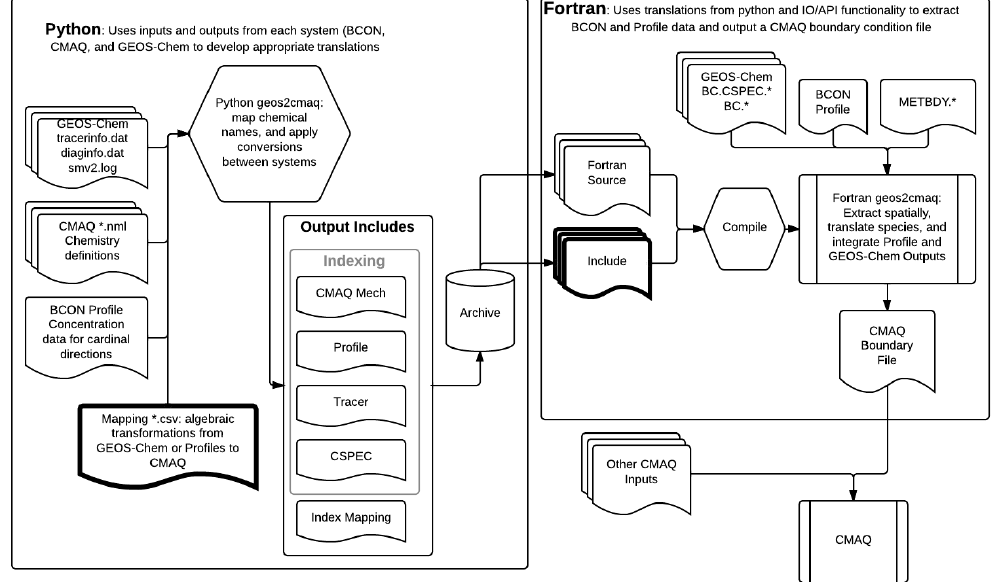
Fig. 2. Program description and flow UML diagram. The BCON and BC.CSPEC.* files are not required. Heavy lined inputs represent geos2cmaq-specific inputs or outputs (i.e., not also necessary for standard run). could be used to develop boundary concentrations for species that are not simulated by GEOS-Chem. In a beta version of the code, arbitrary math functions (e.g., sin) are avail- able, but require advanced knowledge of Python and NumPy ( http://www.numpy.org/). The flexible syntax allows for cre- ative applications to other